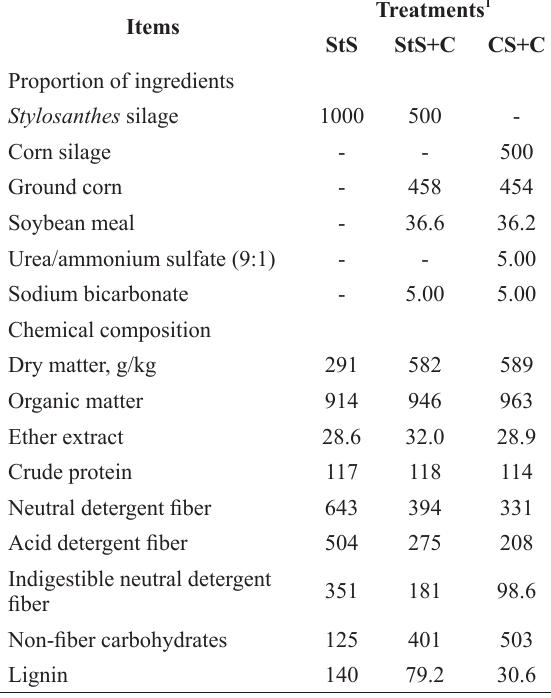
Proportion of ingredients and chemical composition of the diets (g/kg of dry